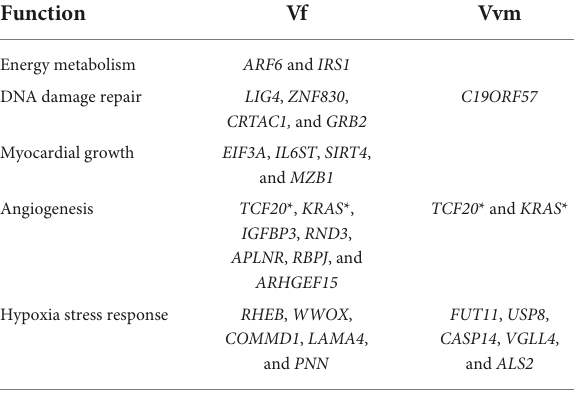
TABLE 3 PSGs related to high-altitude adaption.